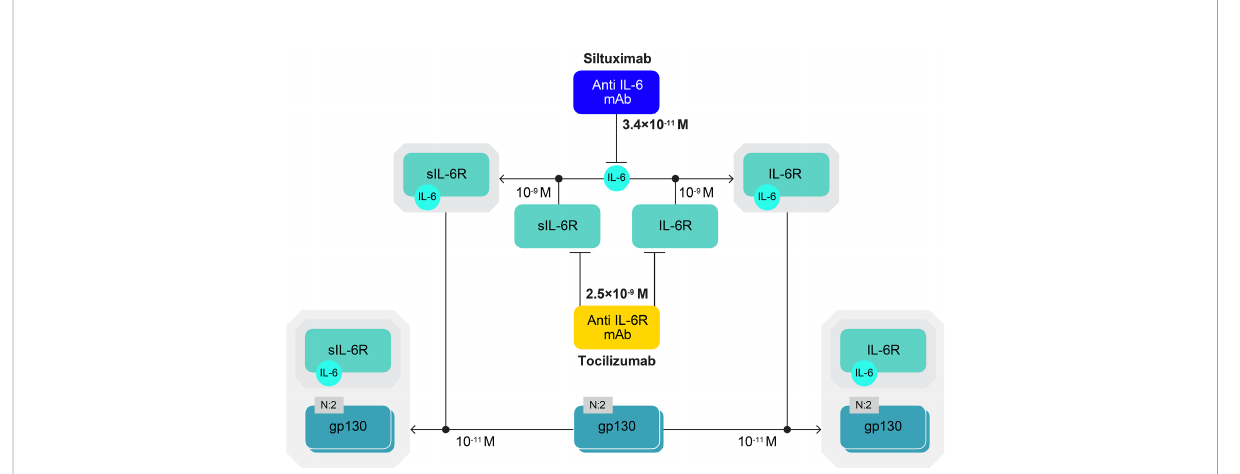
FIGURE 2 IL-6 – (IL-6R/sIL-6R) – gp130 complexes. IL-6 signal transduction is initiated when IL-6 binds to its membrane-bound receptor (IL-6R) or plasma- soluble receptor (sIL-6R) and IL-6 – IL-6R and IL-6 – sIL-6R complexes bind to a membrane glycoprotein transducer (gp130). Af fi nity constants are shown for the IL-6 complex molecules and the anti-IL-6 (siltuximab) and anti-IL-6R (tocilizumab) mAbs, which are approved for use in humans. Siltuximab has a higher binding af fi nity for IL-6 than tocilizumab has for IL-6R. The diagram has been produced following the Systems Biology Graphical Notation. N:2 indicates a multimer with two subunits (e.g. gp130 dimer). gp130, glycoprotein 130; IL-6, interleukin-6; IL-6R, interleukin-6 receptor; mAb, monoclonal antibody; s,